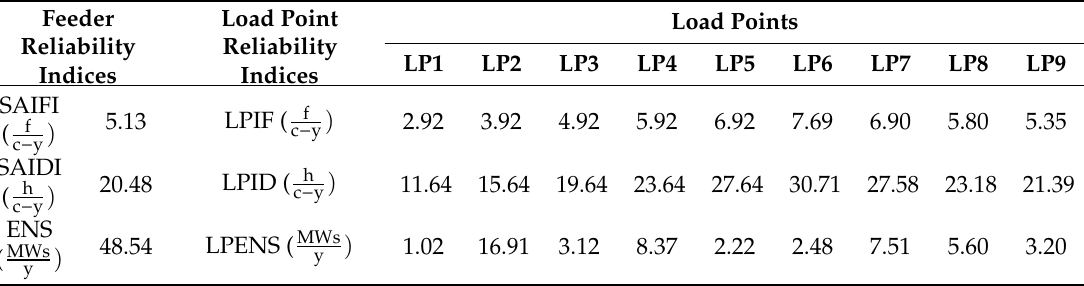
Table 6. Calculated reliability indices for Case-4.